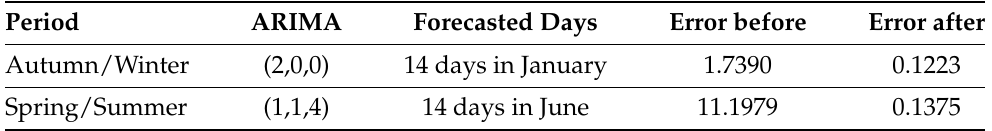
Table 4. Summary for the two restricted